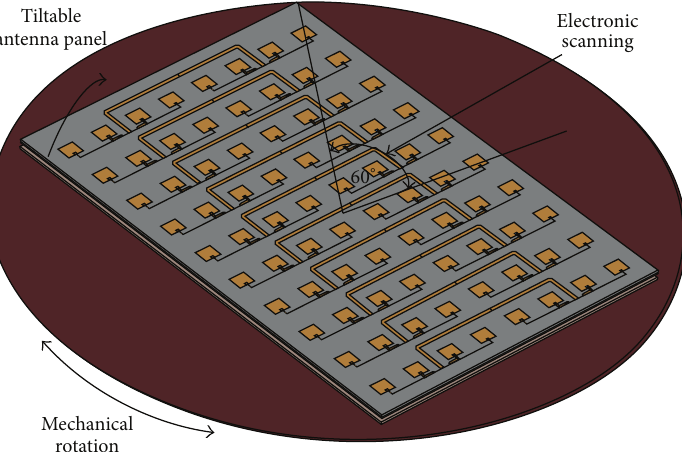
Figure 14: Sketch of the hybrid scanning array